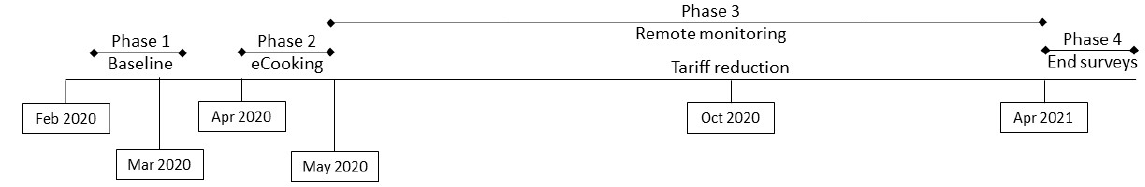
Figure 2. A2EI study timeline.